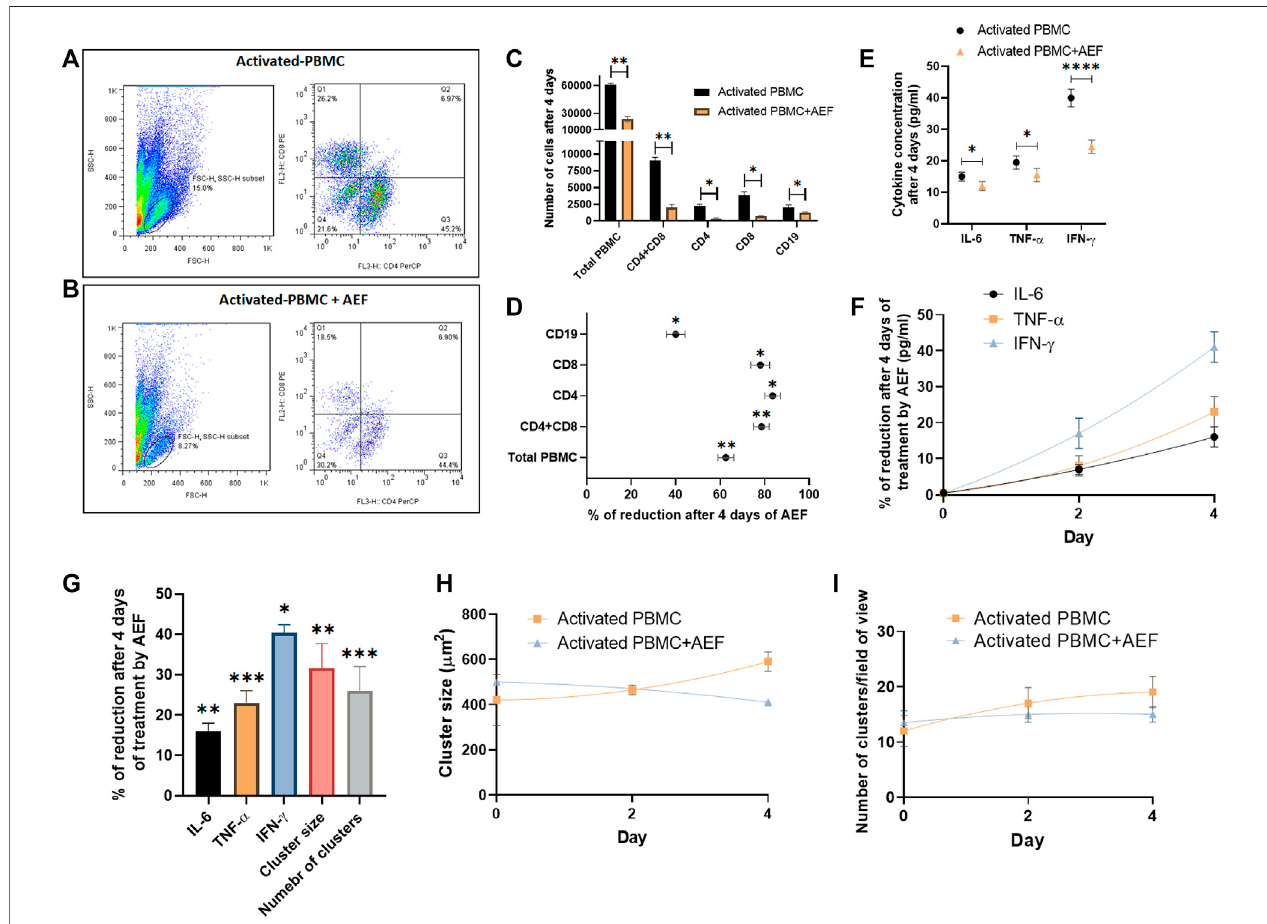
FIGURE 4 | (A, B) Flowcytometry analysis con fi rmed the reduction of activated PBMCs exposed to AEF for 4 days compared to their control group. (C, D) Comparison between the number of cells for each group of lymphocytes in PBMC and their percentage of reduction. (E, F) The decline in the concentration of in fl ammatorycytokinesinPBMCscausedbyAEFstimulationandthedailypercentageofreductionforeachcytokine. (G) Percentageofreductionintheconcentrationof the in fl ammatory cytokines, the cluster size and the number of clusters in the activated PBMCs after 4 days of the AEF treatment. (H, I) comparison between the daily amount of the cluster size and the number of clusters per fi eld of view for the activated PBMCs in control and AEF-stimulated groups. (* p < 0.05, ** p < 0.01, *** p < 0.001, and **** p < 0.0001,